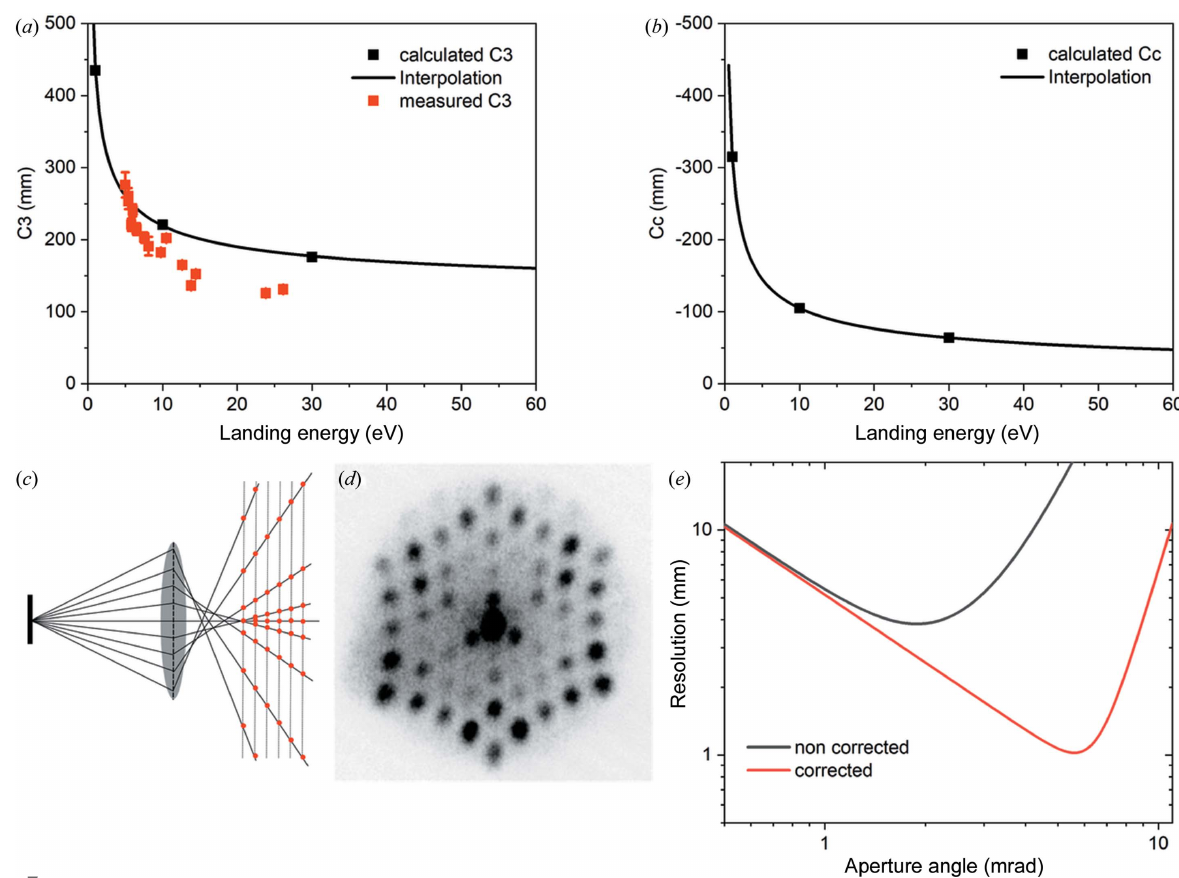
Figure 7 Aberration coefficients and spatial resolution in Elmitec LEEM. Panels ( a ) and ( b ) show calculated spherical (C 3 ) and chromatic (C c ) aberration p coefficients at three different energies 1 eV, 10 eVand 30 eValong with the 1 = ffiffiffiffi E interpolation. The red squares in ( a ) are the experimentally measured C 3 for different energies with real space micro-LEED. ( c ) Schematic of the real space micro-LEED for measuring spherical aberrations in the microscope. ( d ) Experimental real space image of the Si(111) surface, with electron energy 5.4 eV, illumination aperture 10 m m, defocus 25 mA. ( e ) Comparison of the resolution and transmission for the Elmitec microscope with and without the aberration corrector. Electron energy E = 10 eV, and the electron energy spread is 0.25 eV. The correction was carried out by removing only the third-order spherical and chromatic